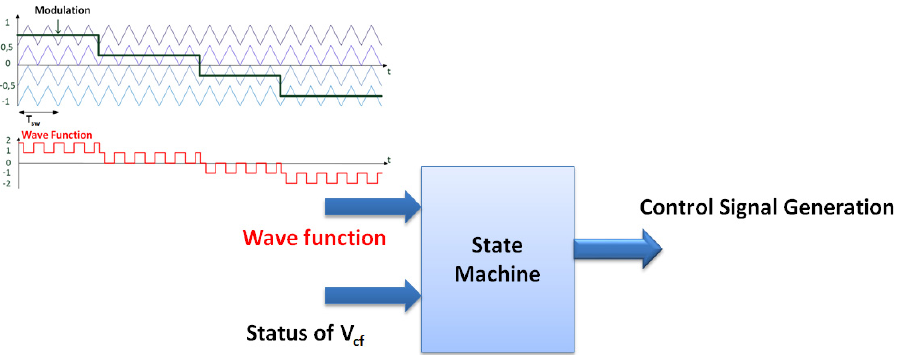
Figure 5. Principle of generating control signals from the state machine for a five-level VIENNA rectifier.